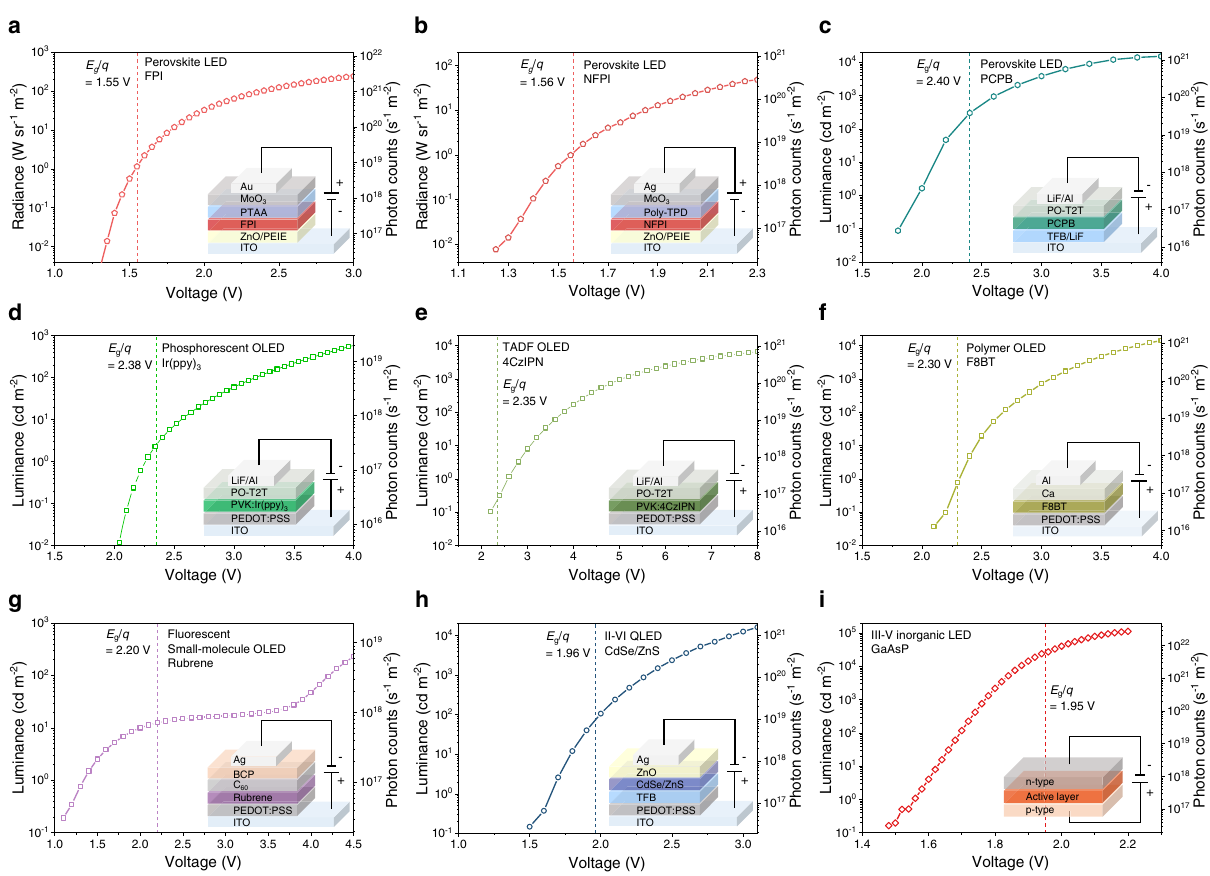
Fig. 1 EL intensity-voltage characteristics of different classes of LEDs. a Near-IR-emitting FAPbI 3 (FPI) perovskite LED. b Near-IR-emitting NFPI perovskite LED. c Green PCPB perovskite LED. d Phosphorescent OLED based on Ir(ppy) 3 . e TADF OLED based on 4CzIPN. f Polymer OLED based on F8BT. g Fluorescent small-molecule OLED based on rubrene. h II – VI QLED based on CdSe/ZnS QDs. i Commercial III – V inorganic LED based on GaAsP. The bandgaps for each emissive material are marked by dashed lines. Insets are schematics of the respective LED device